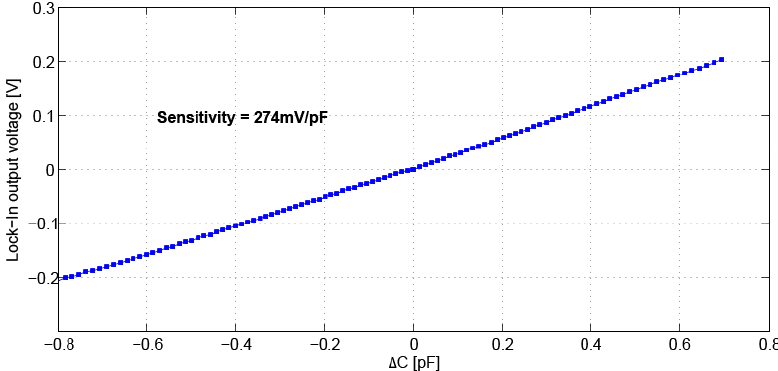
Figure 8. Output response of the capacitive readout block, including digital lock-in.